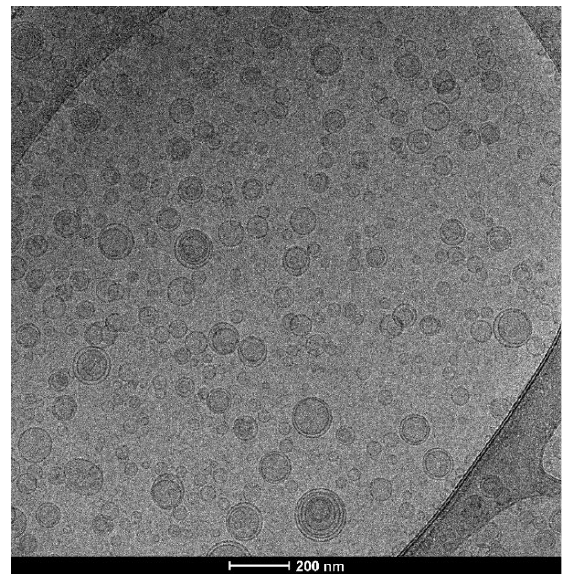
Figure 2. Myrtle liposomes through cryo-TEM observation.